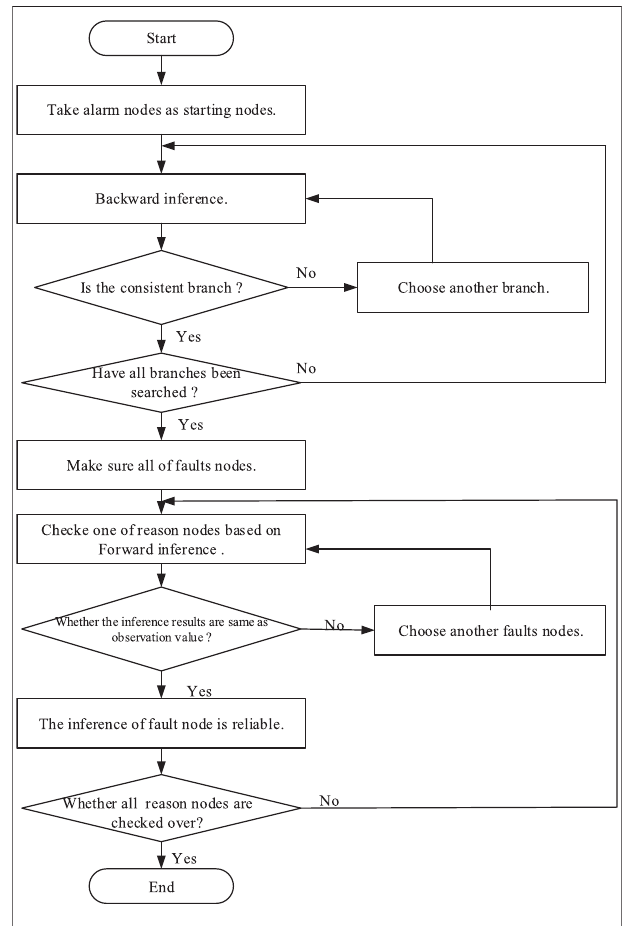
FIGURE 2 | Flow chart of SDG inference.